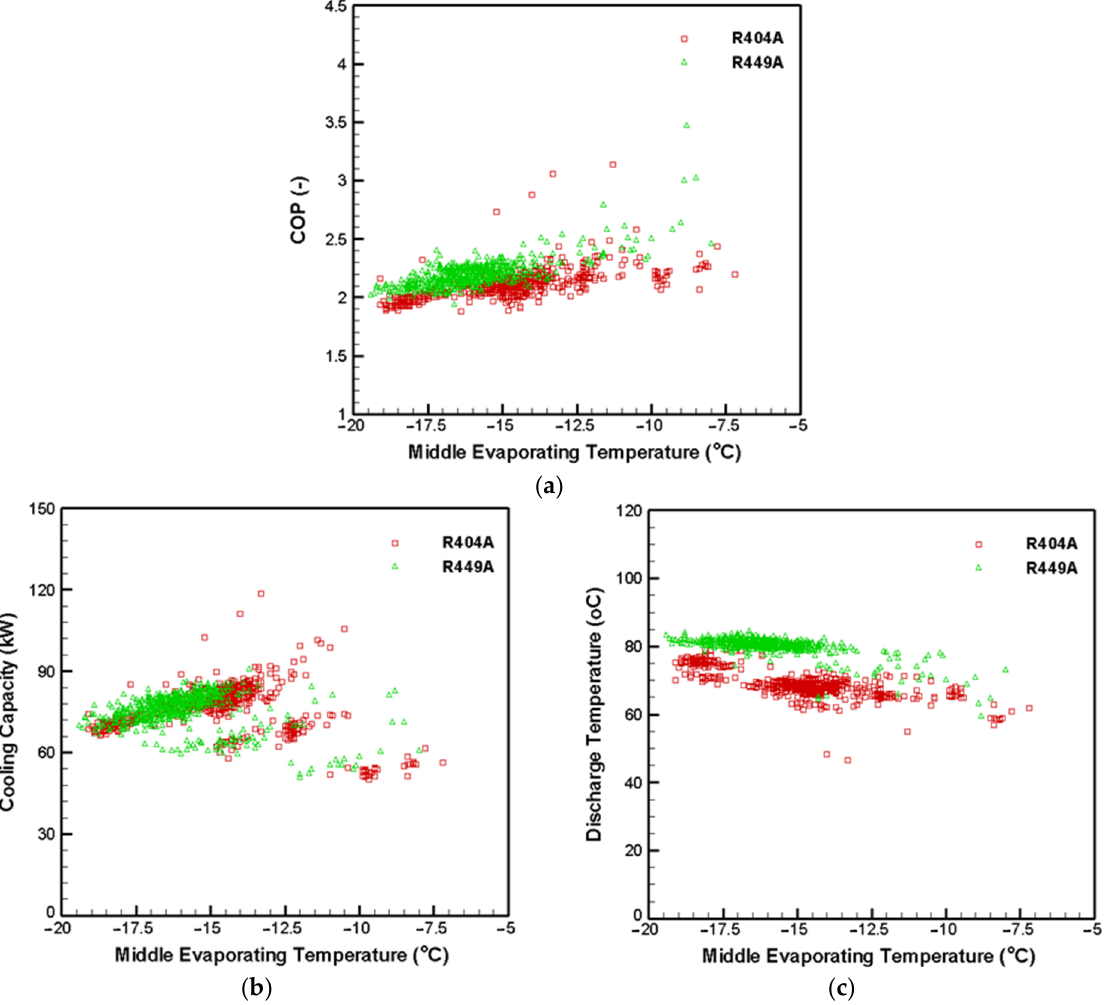
Figure 10. Experimental values for ( a ) COP, ( b ) cooling capacity, and ( c ) discharge temperature of the supermarket refrigeration system at MT application.